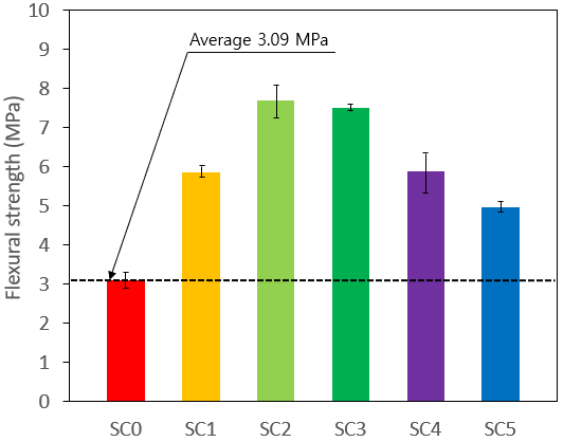
Figure 6. Flexural strength of MFRCM and HyFRCM versus PM.